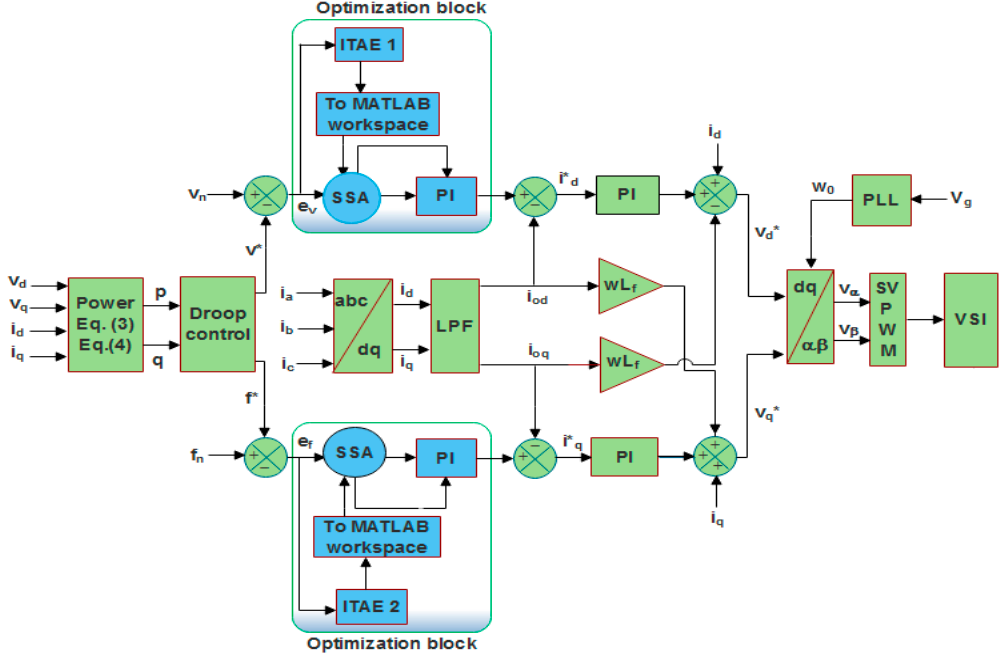
Figure 4. Detailed diagram of the salp swarm optimization algorithm based controller for islanded MG.